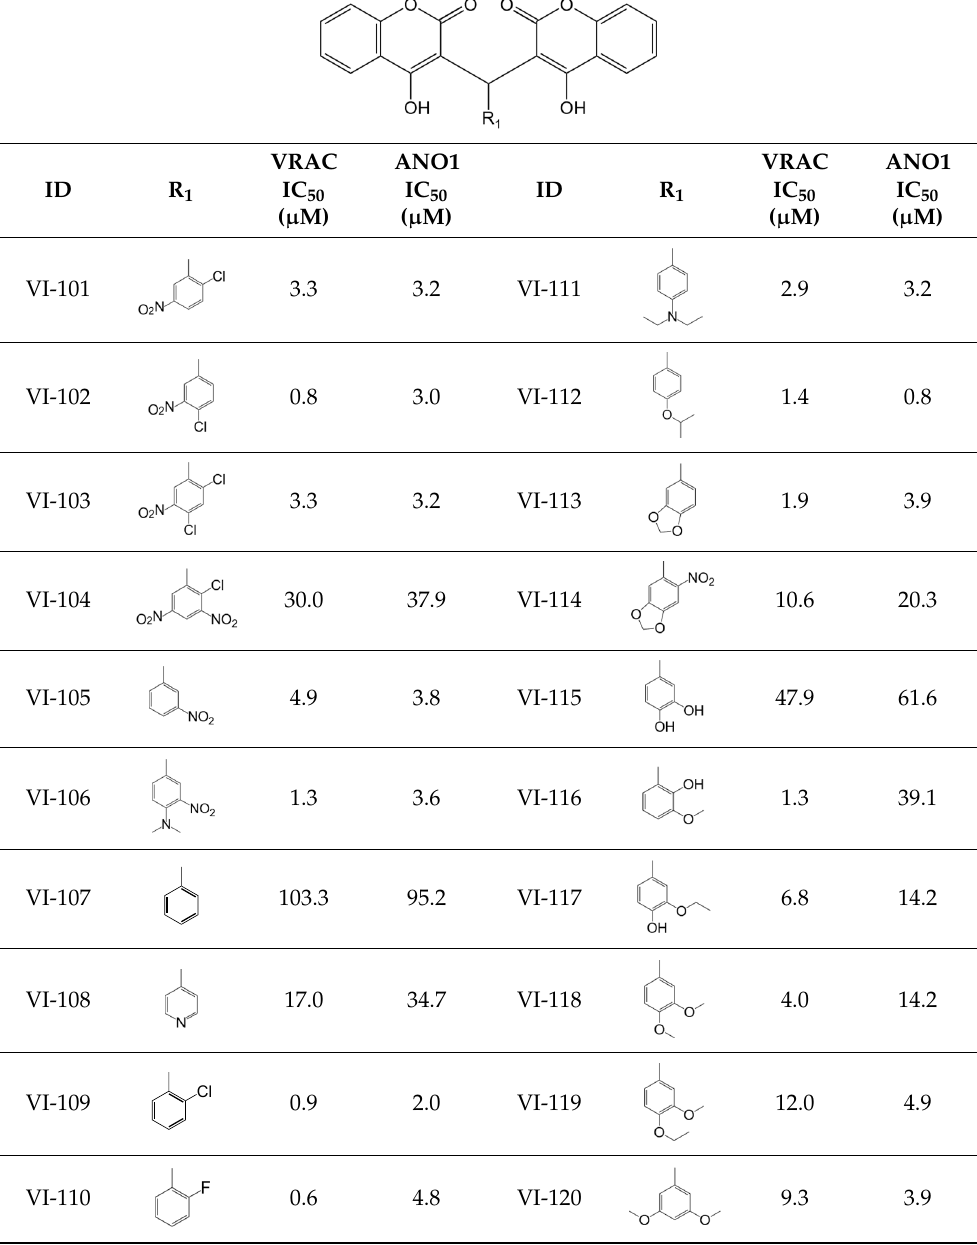
Table 1. Effect of VI-101 derivatives on VRAC and ANO1 activity. IC 50 values were determined using Table 1 . Effect of VI-101 derivatives on VRAC and ANO1 activity. IC 50 values were determined Table 1 . Effect of VI-101 derivatives on VRAC and ANO1 activity. IC 50 values were determined Table 1 . Effect of VI-101 derivatives on VRAC and ANO1 activity. IC Table 1 . Effect of VI-101 derivatives on VRAC and ANO1 activity. IC 50 values were determined 50 values were determined Table 1 . Effect of VI-101 derivatives on VRAC and ANO1 activity. IC 50 values were determined Table 1 . Effect of VI-101 derivatives on VRAC and ANO1 activity. IC 50 values were determined YFP fluorescence quenching assay in LN215 and FRT-ANO1 cells ( n = 4). using YFP fluorescence quenching assay in LN215 and FRT-ANO1 cells ( n = 4). Table 1 . Effect of VI-101 derivatives on VRAC and ANO1 activity. IC 50 values were determined Table 1 . Effect of VI-101 derivatives on VRAC and ANO1 activity. IC 50 values were determined Table 1 . Effect of VI-101 derivatives on VRAC and ANO1 activity. IC Table 1 . Effect of VI-101 derivatives on VRAC and ANO1 activity. IC 50 values were determined Table 1 . Effect of VI-101 derivatives on VRAC and ANO1 activity. IC 50 values were determined Table 1 . Effect of VI-101 derivatives on VRAC and ANO1 activity. IC using YFP fluorescence quenching assay in LN215 and FRT-ANO1 cells ( n = 4). Table 1 . Effect of VI-101 derivatives on VRAC and ANO1 activity. IC 50 values were determined 50 values were determined 50 values were determined Table 1 . Effect of VI-101 derivatives on VRAC and ANO1 activity. IC 50 values were determined Table 1 . Effect of VI-101 derivatives on VRAC and ANO1 activity. IC 50 values were determined Table 1 . Effect of VI-101 derivatives on VRAC and ANO1 activity. IC 50 values were determined Table 1 . Effect of VI-101 derivatives on VRAC and ANO1 activity. IC 50 values were determined using YFP fluorescence quenching assay in LN215 and FRT-ANO1 cells ( n = 4). Table 1 . Effect of VI-101 derivatives on VRAC and ANO1 activity. IC 50 values were determined Table 1 . Effect of VI-101 derivatives on VRAC and ANO1 activity. IC 50 values were determined Table 1 . Effect of VI-101 derivatives on VRAC and ANO1 activity. IC 50 values were determined using YFP fluorescence quenching assay in LN215 and FRT-ANO1 cells ( n = 4). Table 1 . Effect of VI-101 derivatives on VRAC and ANO1 activity. IC 50 values were determined using YFP fluorescence quenching assay in LN215 and FRT-ANO1 cells ( n = 4). using YFP fluorescence quenching assay in LN215 and FRT-ANO1 cells ( n = 4). using YFP fluorescence quenching assay in LN215 and FRT-ANO1 cells ( n = 4). using YFP fluorescence quenching assay in LN215 and FRT-ANO1 cells ( n = 4). using YFP fluorescence quenching assay in LN215 and FRT-ANO1 cells ( n = 4). using YFP fluorescence quenching assay in LN215 and FRT-ANO1 cells ( n = 4). using YFP fluorescence quenching assay in LN215 and FRT-ANO1 cells ( n = 4). using YFP fluorescence quenching assay in LN215 and FRT-ANO1 cells ( n = 4). using YFP fluorescence quenching assay in LN215 and FRT-ANO1 cells ( n = 4). using YFP fluorescence quenching assay in LN215 and FRT-ANO1 cells ( n = using YFP fluorescence quenching assay in LN215 and FRT-ANO1 cells ( n = 4).